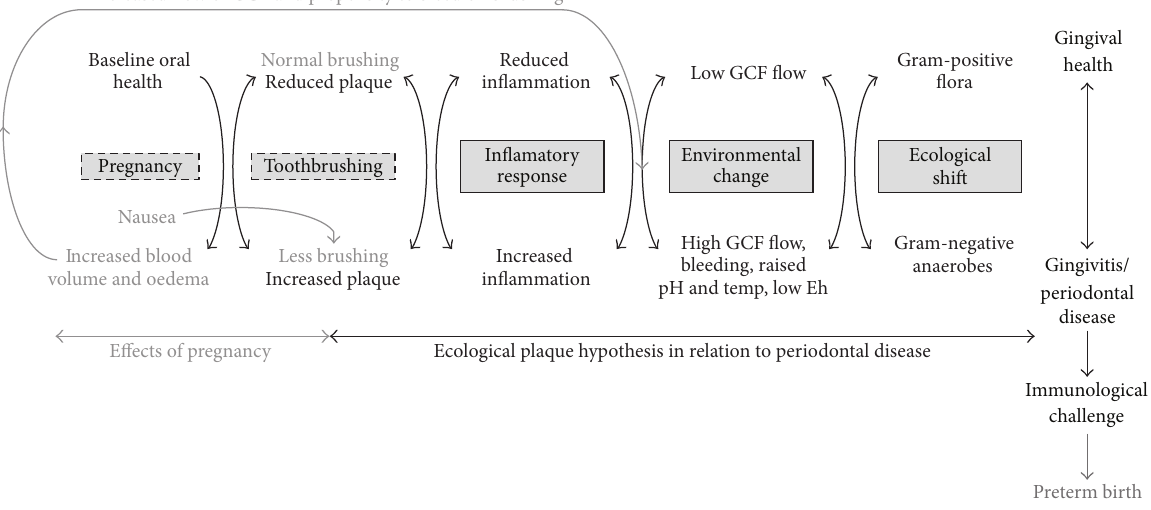
Figure 5: Proposed interrelationship between the changes occurring in the maternal gingiva superimposed upon changing tooth brushing habits during pregnancy and their interaction with the plaque environment and microbiota as proposed in the ecological plaque hypothesis. Eh, redox potential. Figure adapted with permission from